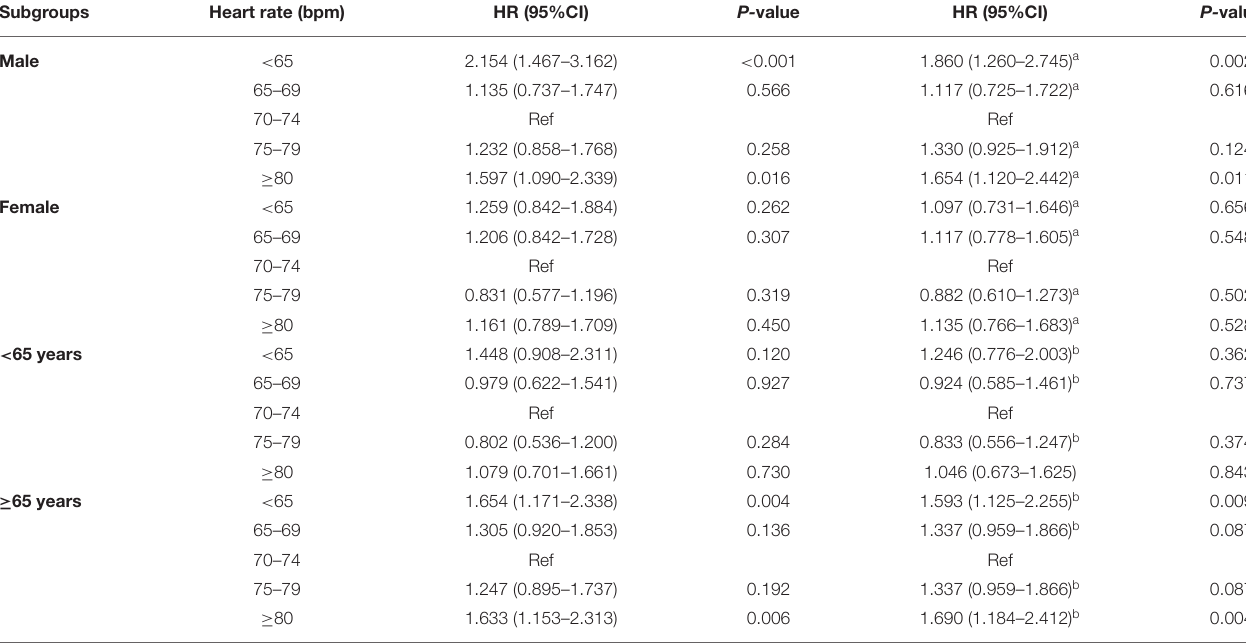
TABLE 3 | Association between heart rate and MACE risks in subgroups of gender and age. Subgroups